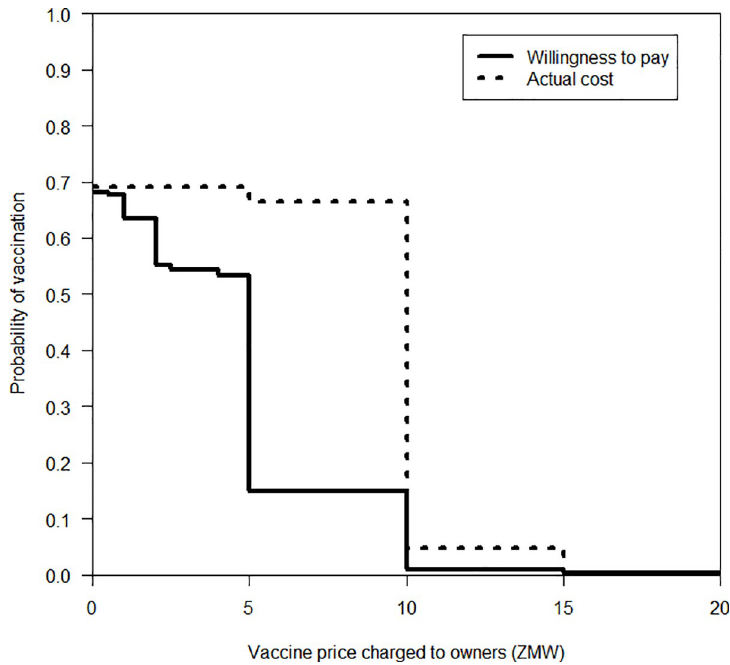
Fig 2. Expected probability of vaccination based on the vaccine price. The solid line shows the reverse cumulative vaccination probability curve for the amount that owners are willing to pay for a single canine rabies vaccination. The broken line shows the reverse cumulative vaccination probability curve for the amount that owners have actually paid for a single canine rabies vaccination. These vaccination probability curves are based on data collected from the household